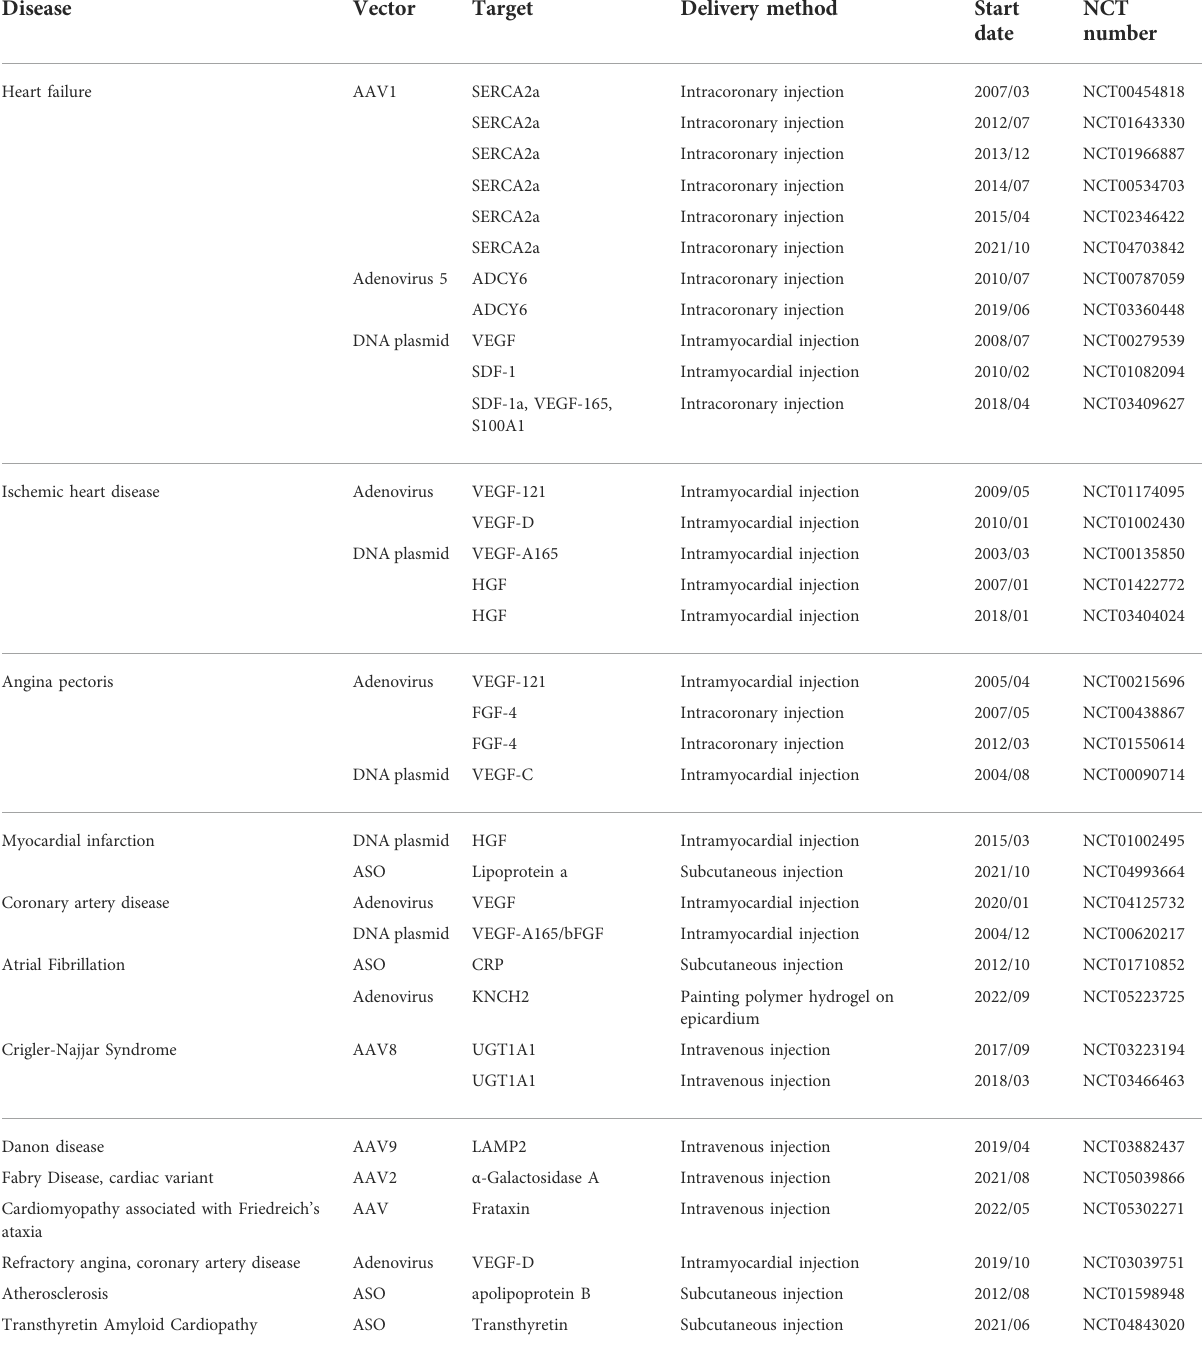
TABLE 2 Clinical trials of gene therapy for cardiac